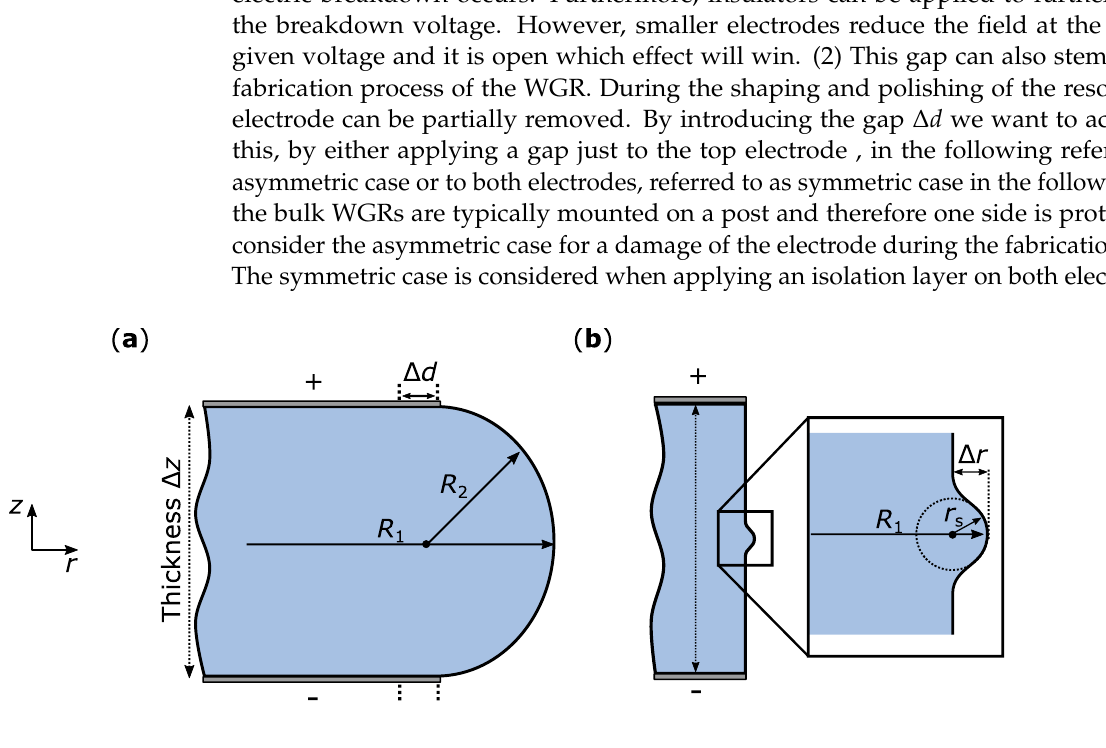
Figure 2. Geometries used for the simulation. We assume an axially symmetrical 2D model. The resonator has at the bottom and top a metal electrode. In ( a ) the geometry with a constant ratio is illustrated. Here R 1 is the major radius, R 2 the minor radius and ∆ z the thickness. For this shape we also investigated a variation of the distance ∆ d between the rim of the resonator and the electrode. ( b ) The few-mode geometry. The small bulge at the equator of the WGR is used to guide the light. Here r s is the radius of the small circle and the distance ∆ r between the rim of the resonator and R 1